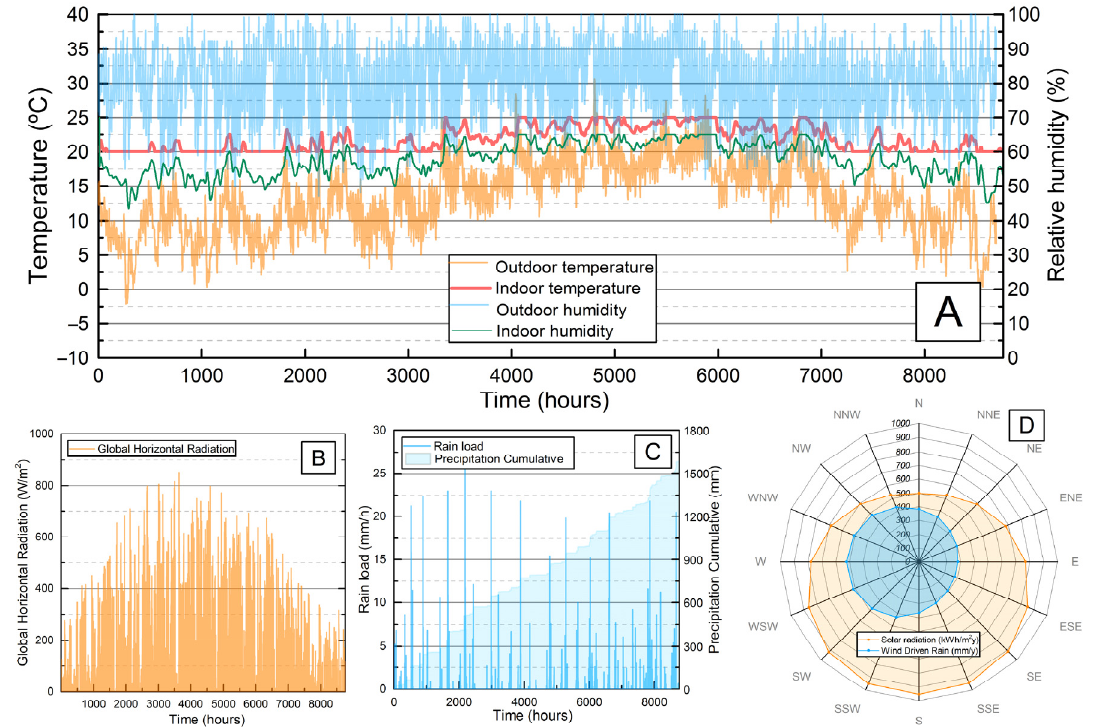
Figure 6. External and internal environmental conditions for the simulation model: ( A ) temperature and humidity, ( B ) solar radiation, ( C ) precipitation, and ( D ) wall radiation and wind-driven rain.